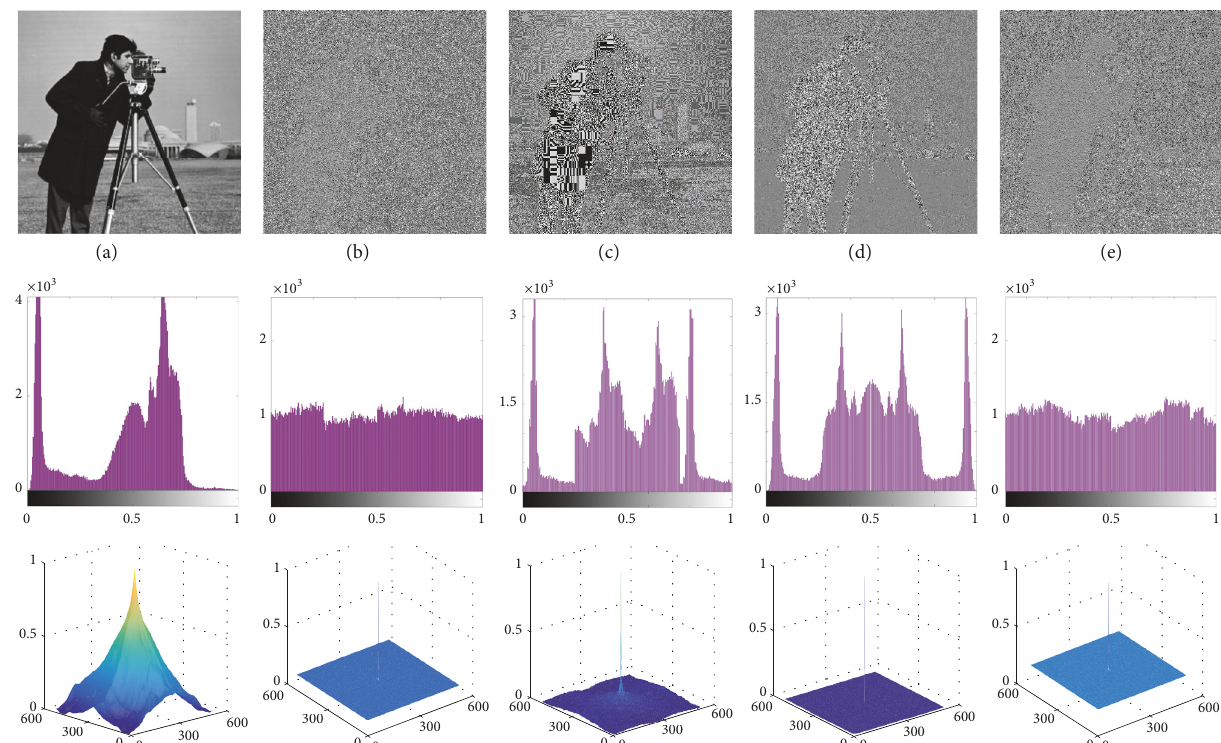
Figure 4: Comparative experiment of “Camera man”: (a) original image, (b) 2D-SLMM, (c) SBE-LBP, (d) BPE-XOR, and (e) method of using 2D-SLMM to modulate original image. The second row shows their corresponding histograms and the third row shows their corresponding autocorrelation images.